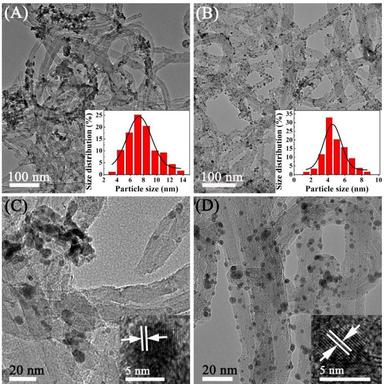
TEM images of Pd/CNTs (A, C) and Pd/CNTs-DPHE-2 (B, D). Inset in (A) and (B) are the Pd nanocrystals size distribution histogram. Inset in (C) and (D) are HRTEM images of the Pd nanocrystals.